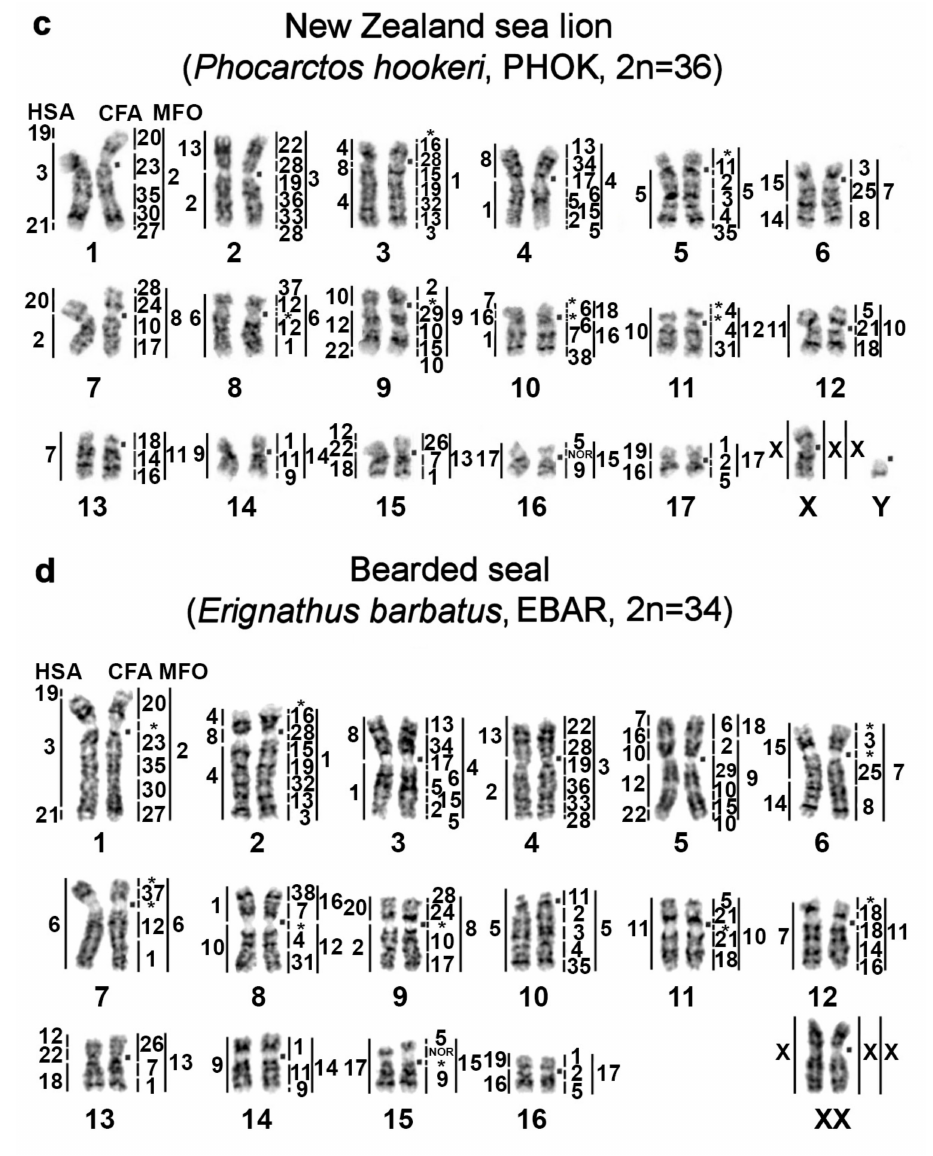
Figure 1. GTG banded karyotypes of ( a ) the New Zealand fur seal (AFOR, 2n = 36), ( b ) northern fur seal (CURS, 2n = 36), ( c ) New Zealand sea lion (PHOK, 2n = 36), and ( d ) bearded seal (EBAR, 2n = 34) with the assignment of homology to human (HSA), dog (CFA), and stone marten (MFO) chromosomes. Nucleolus organizer regions are marked as NOR. The square denotes a centromere position on the corresponding chromosome. * Heterochromatin regions not painted by any dog